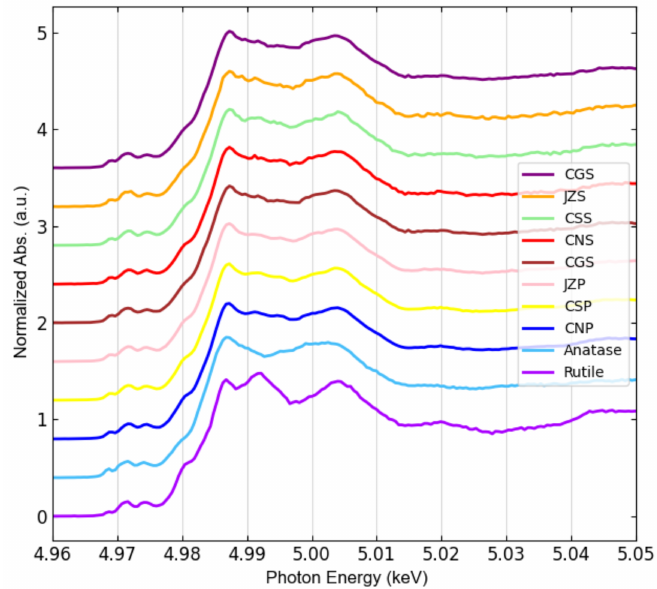
Figure 4. Bulk Ti K-edge XANES spectra of sludge samples, including rutile and anatase references. A vertical offset has been applied to help the comparison.